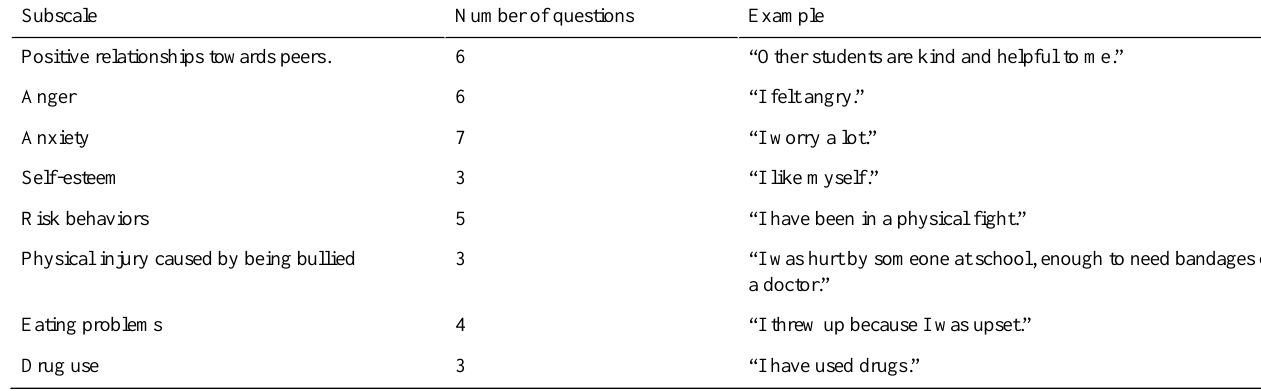
Table 2. Subscales for rating behavioral experiences